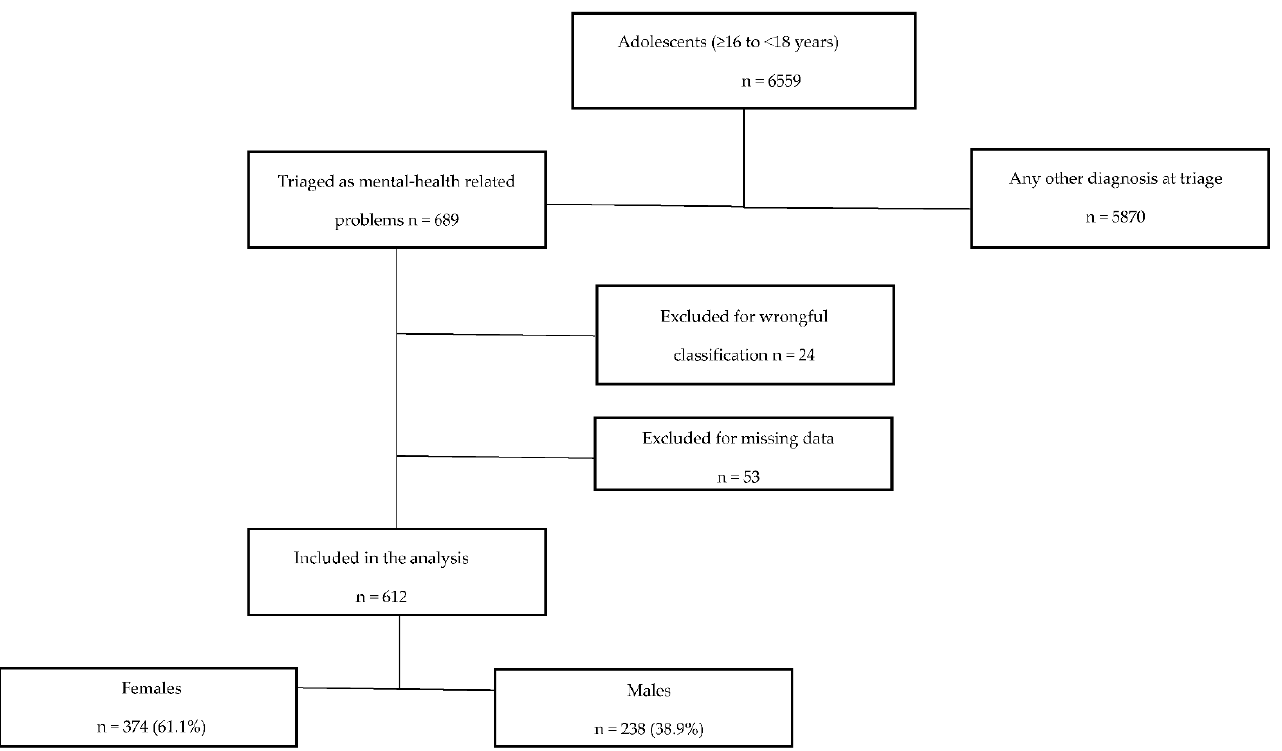
Figure 1. Flow chart of group selection. final total of 612 cases included in the statistical analysis. A total of 61.1% of all cases were female patients (n = 374), compared to 38.9% male patients (n = 238), corresponding to a ratio of 1.6:1 (female: